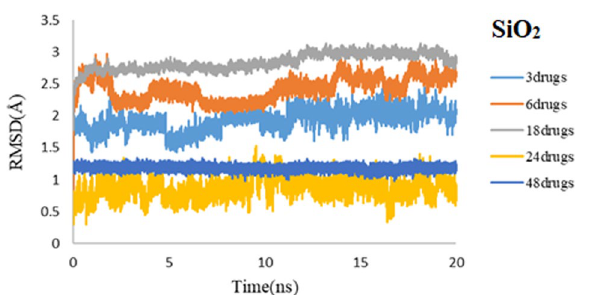
Figure 15. RMSD values of 3TC-SiO 2 complex for 3, 6, 18, 24, and 48 drug molecules during 20 ns simulation time.